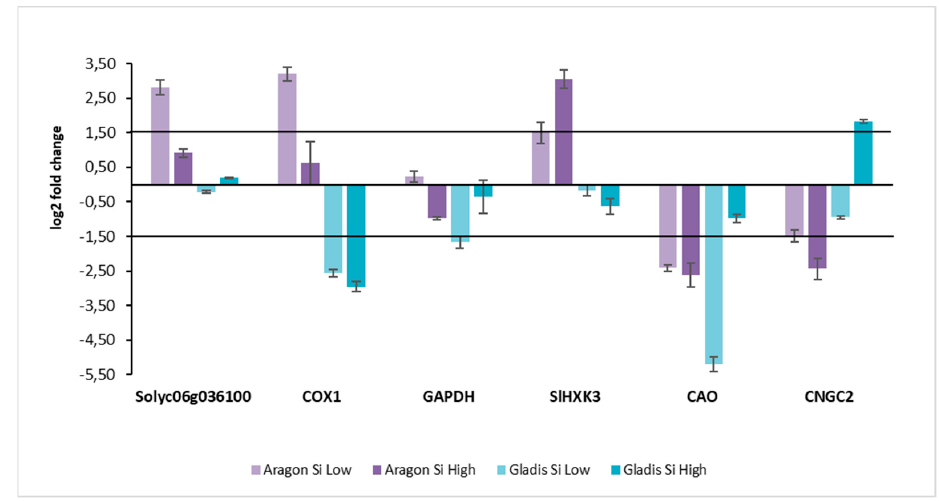
Figure 10. Genes expression values obtained by RT-PCR. Color bars: light purple Aragon treatment Si Low; Dark Purple Aragon treatment Si High; Light cyan Gladis treatment Si Low; Dark cyan Gladis treatment Si High. All the measures have been normalized with the respective Controls. Data were normalized on NT samples. Black horizontal lines: Log2 fold change threshold set at 1.5 and − 1.5 for the significativity of the expression values. Genes are at the bottom, from left to right: Solyc06g036100 (putative LSI2-like silicon efflux transporter), COX1 (Cytochrome c oxidase I), GAPDH (NAD-dependent glyceraldehyde-3-phosphate dehydrogenase), Sl HXK3 (hexokinase), CAO (Chlorophyllide a oxygenase), and CNGC2 (Nucleotide-Gated Channel 2).